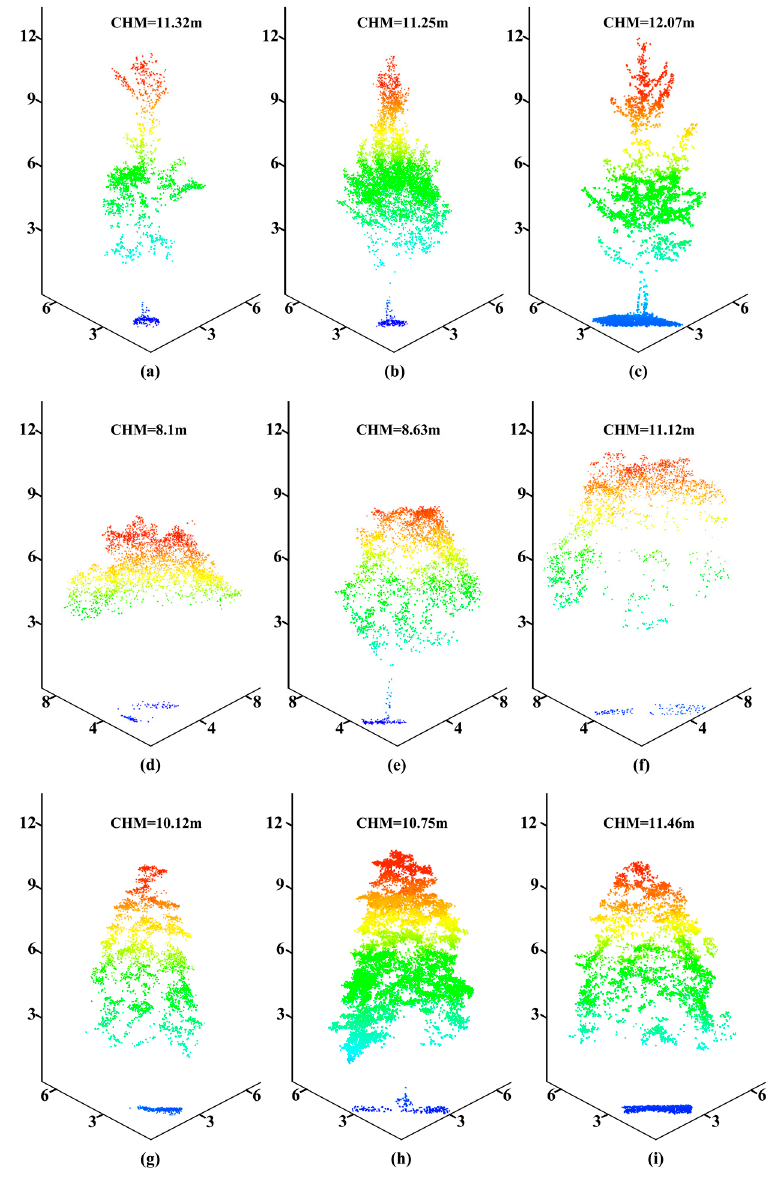
Figure 11. Point cloud chart of single-tree points; among them, the tree numbers indicated by ( a – i ) are GB8, GB13, GB27, CC45, CC46, CC47 YD3, YD36, and YD37, respectively.